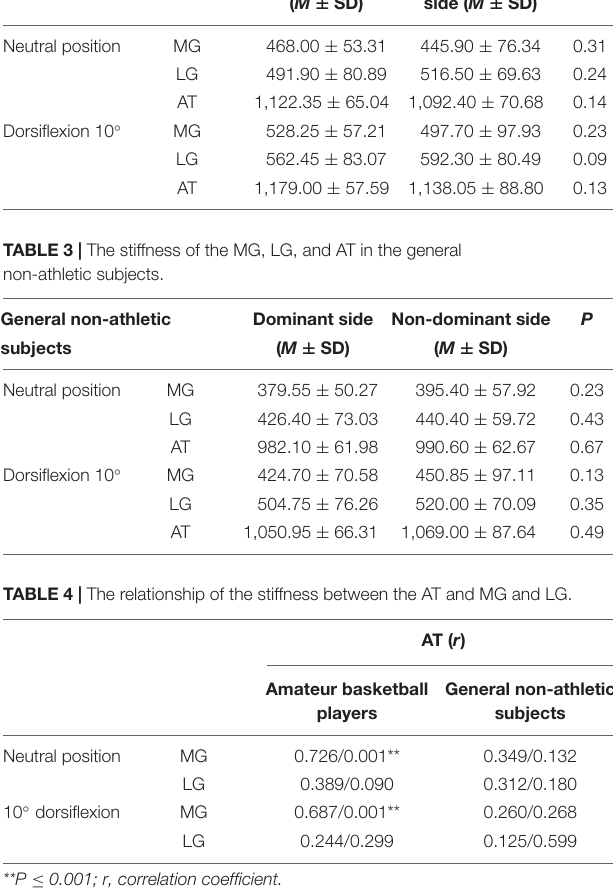
non-athletic subjects (1,179.00 ± 57.59 vs. 1,050.95 ± 66.31;